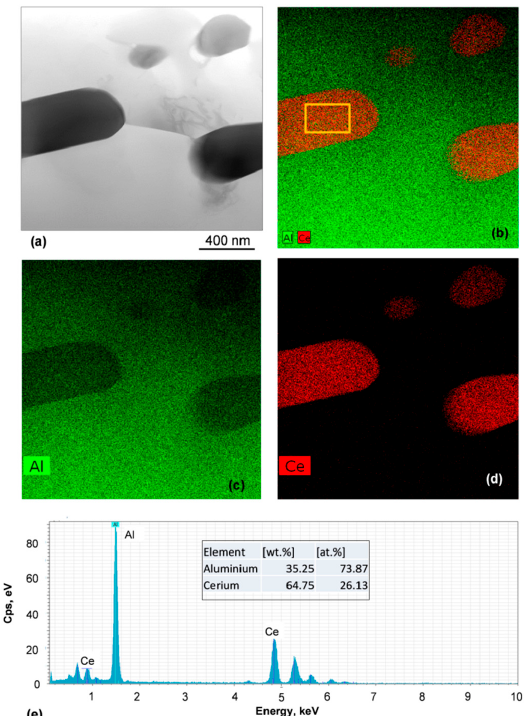
Figure 12. Chemical characterization of the Al 11 Ce 3 lamellae: ( a ) bright field TEM image; ( b – d ) distribution map of Al and Ce; ( e ) EDS quantification of lamella composition from the area shown in ( b ) Alloy: Al–5Ce.